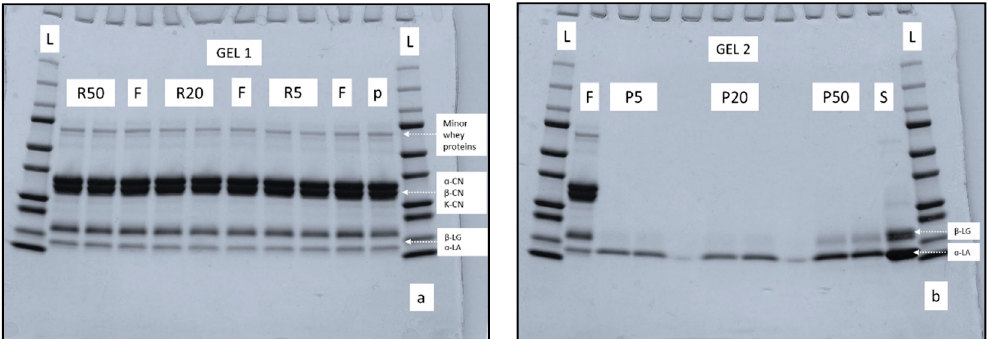
Figure 5. Electrophoretic patterns under reducing conditions of ( a ) retentate and ( b ) permeate samples obtained by ultrafiltration of skim milk at 5 ± 0.5, 20 ± 0.5, and 50 ± 0.5 °C. Bands represent samples from two independent runs at each processing temperature. L: ladder; F: feed; R: retentate; P: permeate; p: low-heat skim milk powder; S: α -LA standard; α -CN: α -casein; β -CN: β -casein; κ -CN: